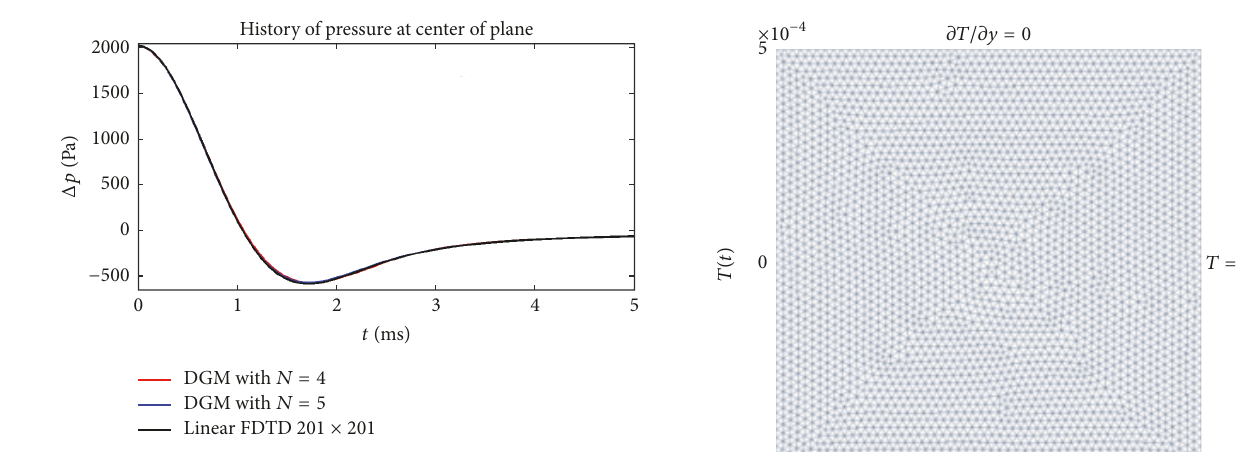
Figure 5: Pressure history at domain center ( 𝑥 = 0 and 𝑦 = 0 ) comparisonfortheFiniteDifferenceTimeDomain(FDTD)method and DG method at orders 4 and 5.